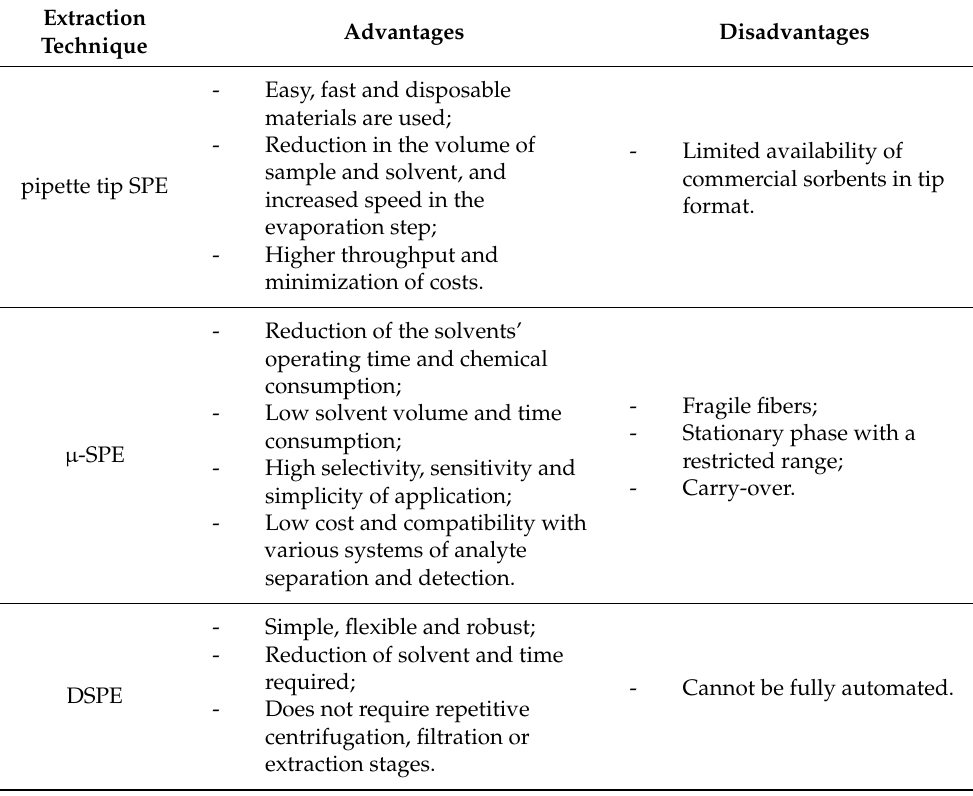
Table 5. Advantages and disadvantages of the pipette tip SPE, µ -SPE and DSPE procedures.